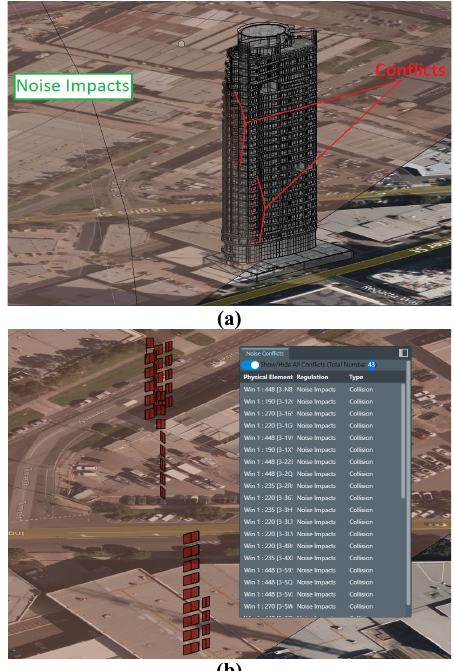
(b) Figure 12 . Detected noise impacts conflicts (coloured in red)